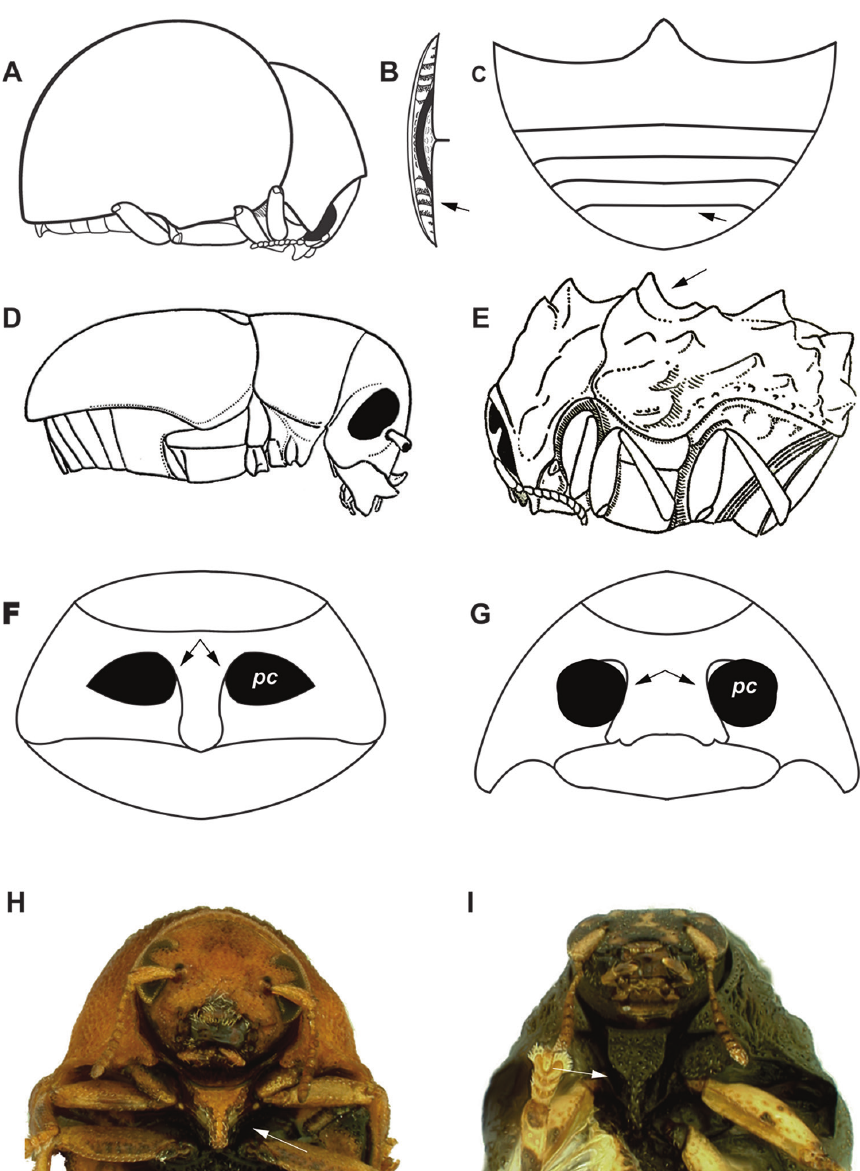
Figure 2. Diagnostic characters plate 1. A Body dorsally highly convex and ventrally flattened (semi- circular in cross-section (drawn after Monrós 1956) B Distal margin of last ventrite thick (drawn after Chamorro and Konstantinov 2011) C Last ventrite not excised in shape of arc D Body cylindrical, not flattened ventrally (drawn after Monrós 1953a) E body surface usually tuberculate (drawn after Monrós 1951) F procoxae prominent and contiguous G procoxae not prominent and separated H prosternal process more than 3/4 as long as intercoxal prosternal process (after Chamorro-Lacayo and Konstantinov (2009) I intercoxal prosternal process gradually constricted at about 2/3 of its length (after Chamorro- Lacayo & Konstantinov